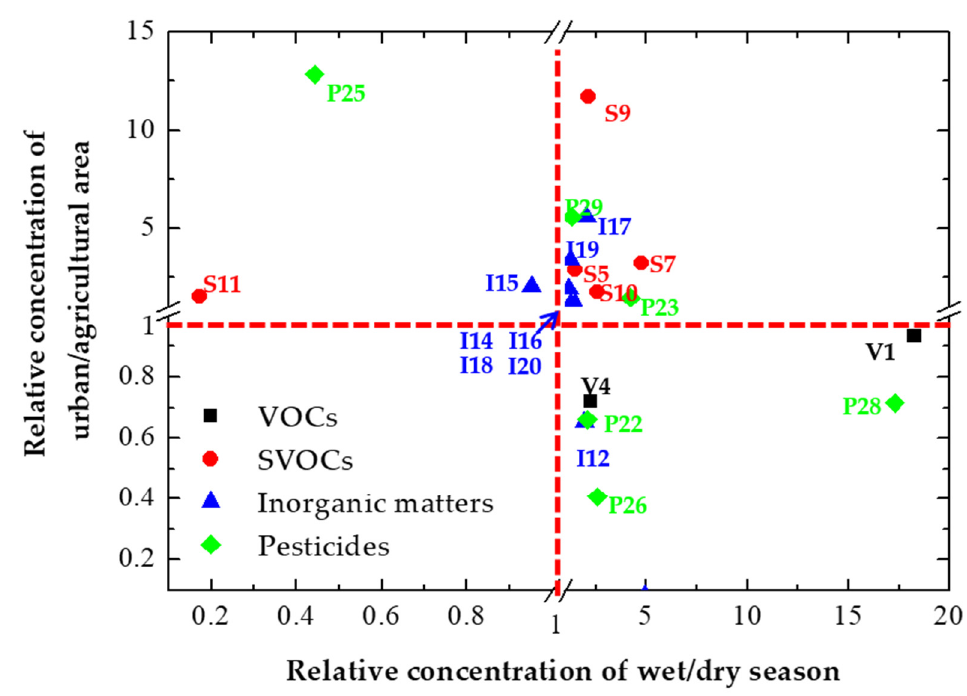
Figure 5. Distribution of relative concentrations of hazardous substances by season and land use (V; VOCs, S; SVOCs, I; Inorganic matters, P; Pesticides, the number after the alphabet indicates each hazardous substance, see Table 1).